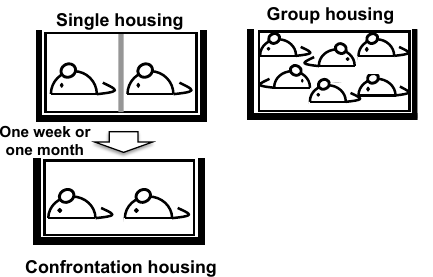
Figure 5. Confrontational housing as a psychosocial stress loading scenario. To create confrontational housing, a standard polycarbonate cage was divided into two identical subunits with a stainless-steel partition (single housing). Two mice were housed in the partitioned cage for one week (for a short-term experiment) or one month (for a long-term experiment). Then, the partition was removed, and, subsequently, the two mice co-inhabited the same cage (confrontational housing). Group-housed mice were housed in groups of six as a control housing scenario. These mice ingested water with or without theanine (6 mg/kg).